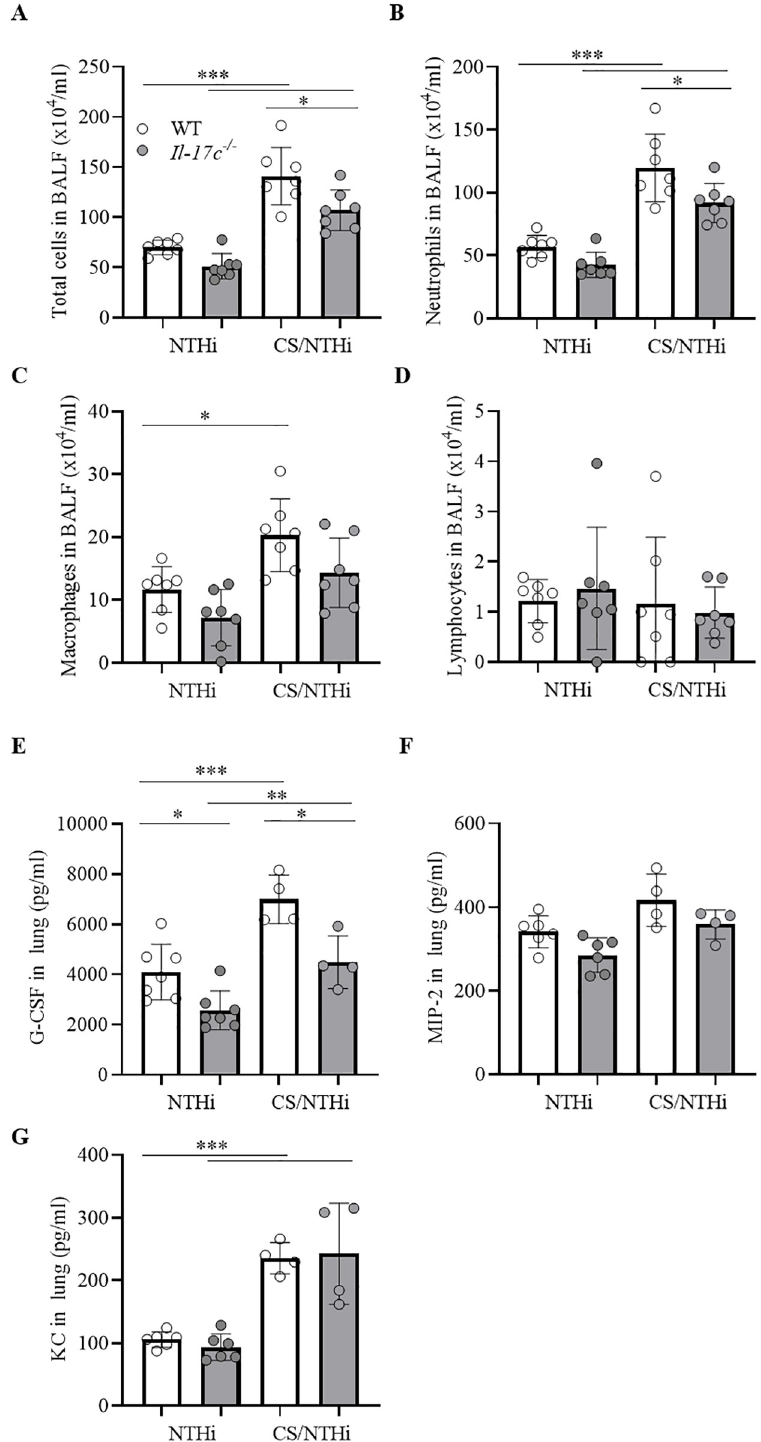
Fig 5. IL-17C contributes to acute COPD-like lung inflammation. WT and Il-17c -/- mice were exposed to NTHi (day 1, 3, and 5) or the combination of NTHi (day 1, 3, 5) and CS (day 1 to 5). Numbers of total immune cells (A), neutrophils (B), macrophages (C), and lymphocytes (D) were determined in BAL fluids 24 hours after the final exposure to NTHi (n = 7 per group). Concentrations G-CSF (E), MIP-2 (F), and KC (G) were measured in lung homogenate (n = 4–7 mice per group). Data were compared by One-way ANOVA with Bonferroni post-test and are shown as the mean ± SD. � p < 0.05, �� p < 0.01, and ��� p < 0.001.